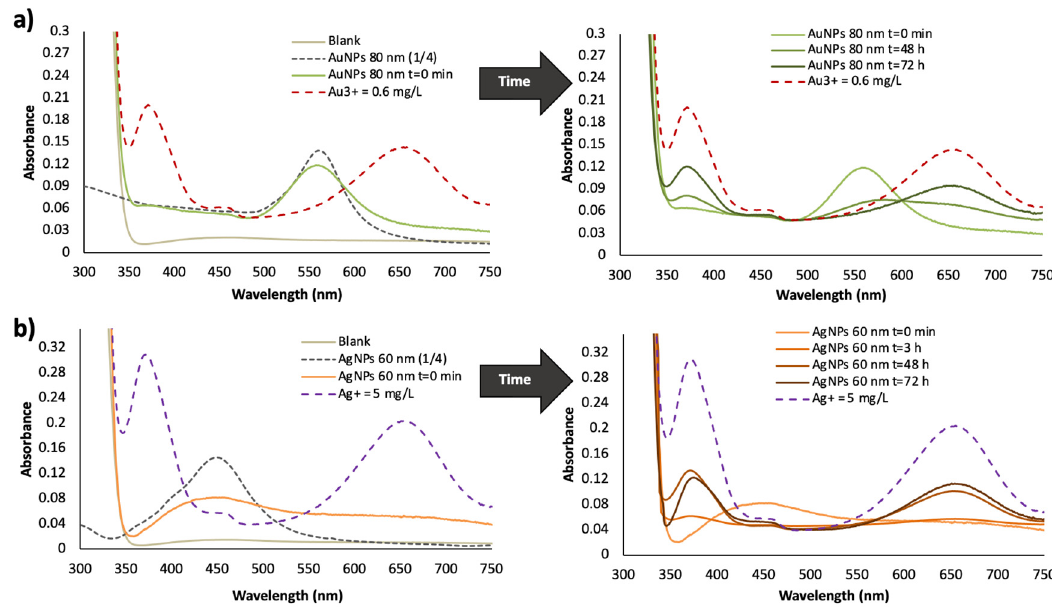
Figure 7. Gold and silver nanoparticles dissolution TMB assay for several times of preparation of diluted dispersions from batch NPs: ( a ) AuNPs for 0, 48 and 72 h and ( b ) 0, 3, 48 and 72 h. For more explanation see text.